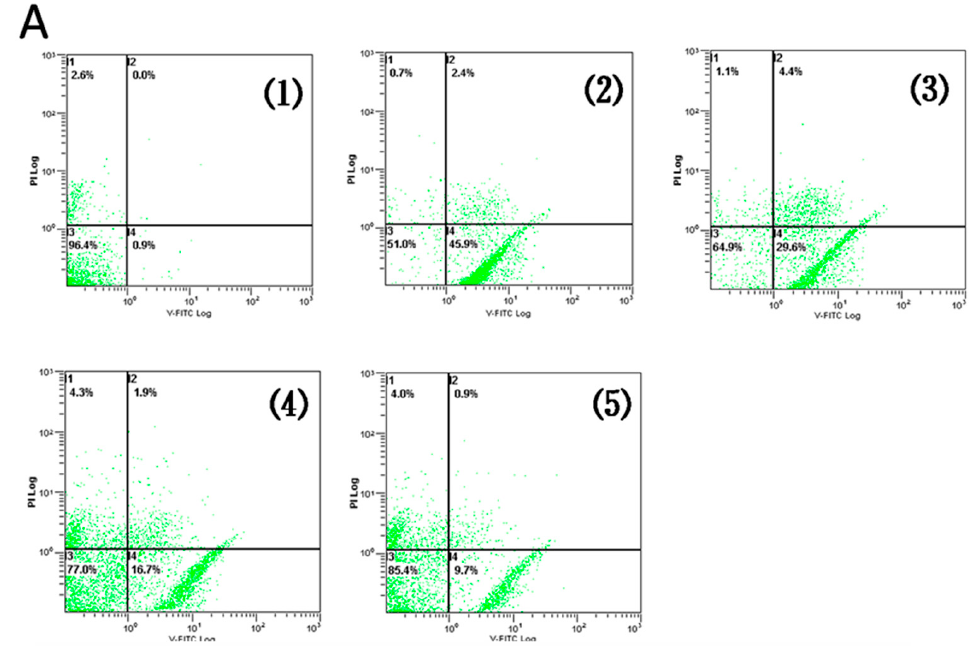
Figure 2. Effects of AR on H9c2 cardiomyocytes viability. After treatment with AR (1, 10, 100 μ M) for 24 h, H9c2 cardiomyocytes were treated with H/R injury. Cells viability was analyzed by [3-(4,5-dimethylthiazol-2-yl)-2,5-diphenyltetrazolium bromide] (MTT) assay, and the value of